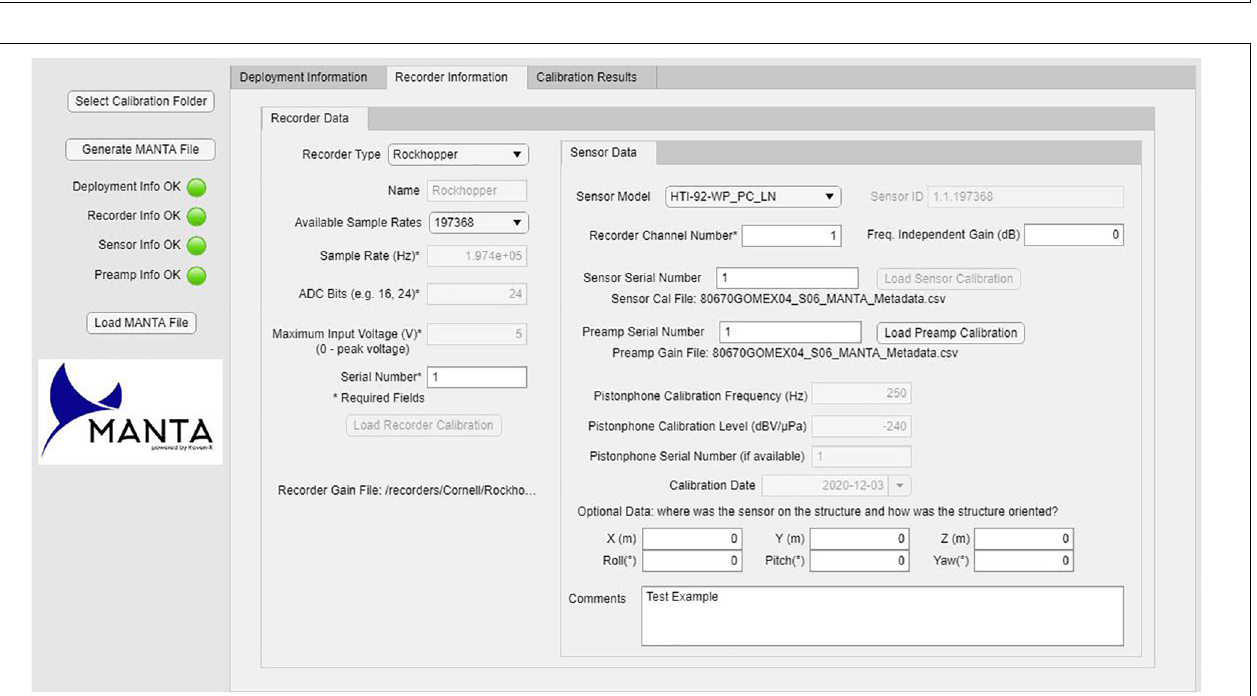
FIGURE 1 | MANTA Metadata App Deployment Information graphical user interface (GUI) for deployment information. When the deployment information is fully entered and correct, the Deployment Info OK button on the left side bar turns green. Either hydrophone and microphone can be specified on the Sensor Type. Note that selecting “hydrophone” implicitly assumes depth below sea surface, whereas microphone assumes height above sea level. Note: users can specify different instrument start, deployment, and analysis dates. The MANTA Data Mining App will only process data within the analysis dates. This function allows for users to specify the analysis period that does not include any potentially contaminated data at the beginning and end of deployments.